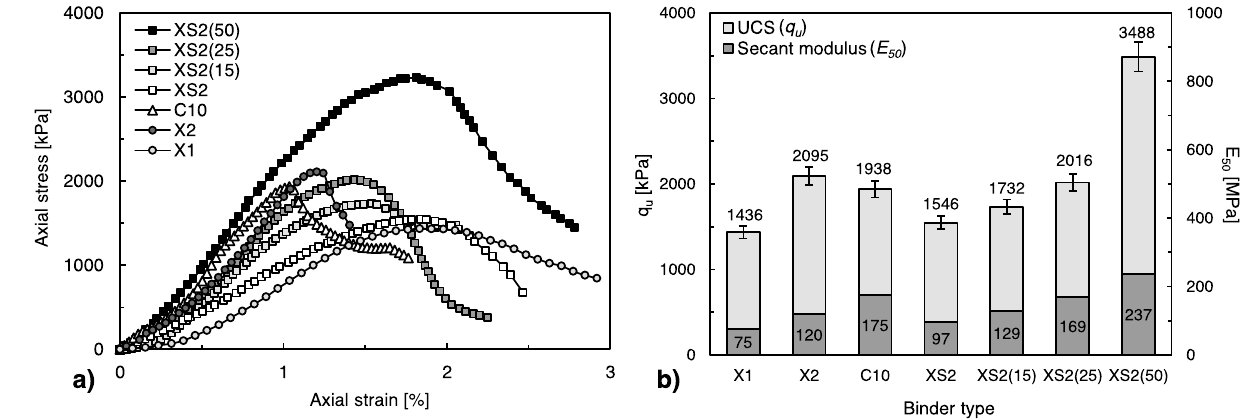
Figure 5. Stress–strain development and strength parameters for controls (0 cycles).